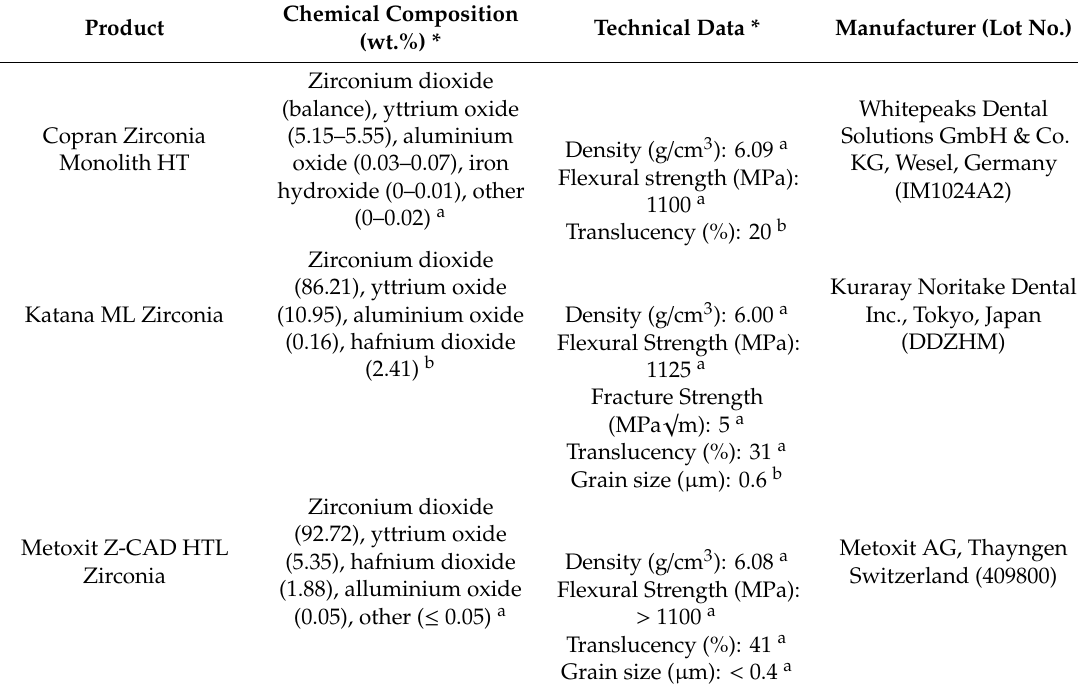
Table 1. Characteristics of the zirconia ceramics tested in the present report, according to data published by manufacturers and literature